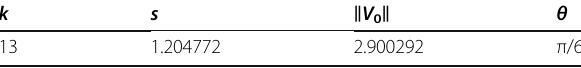
Table 3 The specific data of typical curves with different degree